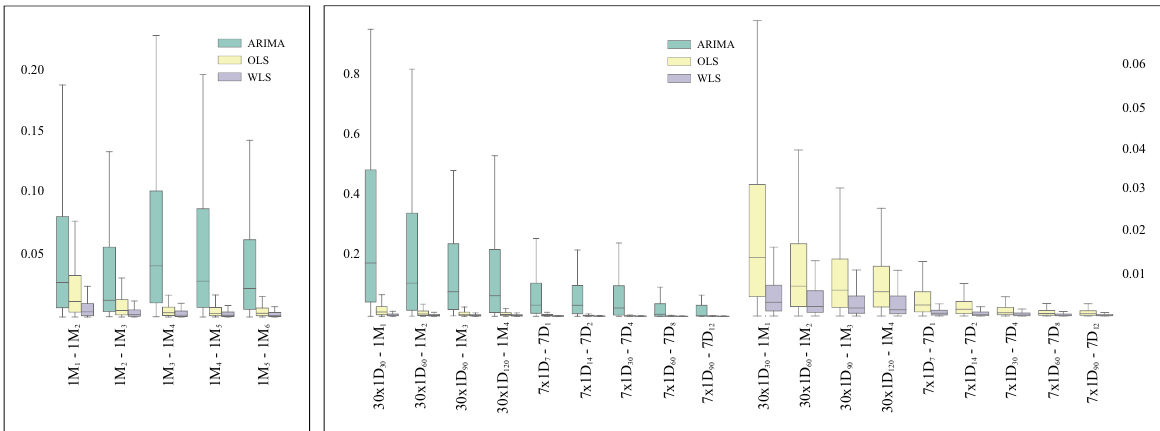
Figure 2. Distribution of paired SART distances. Comparison of ordinary least squares (OLS), weighted least squares (WLS) and autoregressive integrated moving average (ARIMA) in the following scenarios: consecutive periods ( left ) and equivalent granularities ( right ). An additional graph including exclusively OLS and WLS has been added on the latter to facilitate their comparison. The x-axis represents couplets of configurations to generate resistance time series under